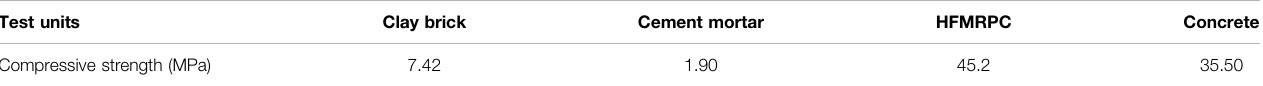
TABLE 3 | Compressive strength of the materials.